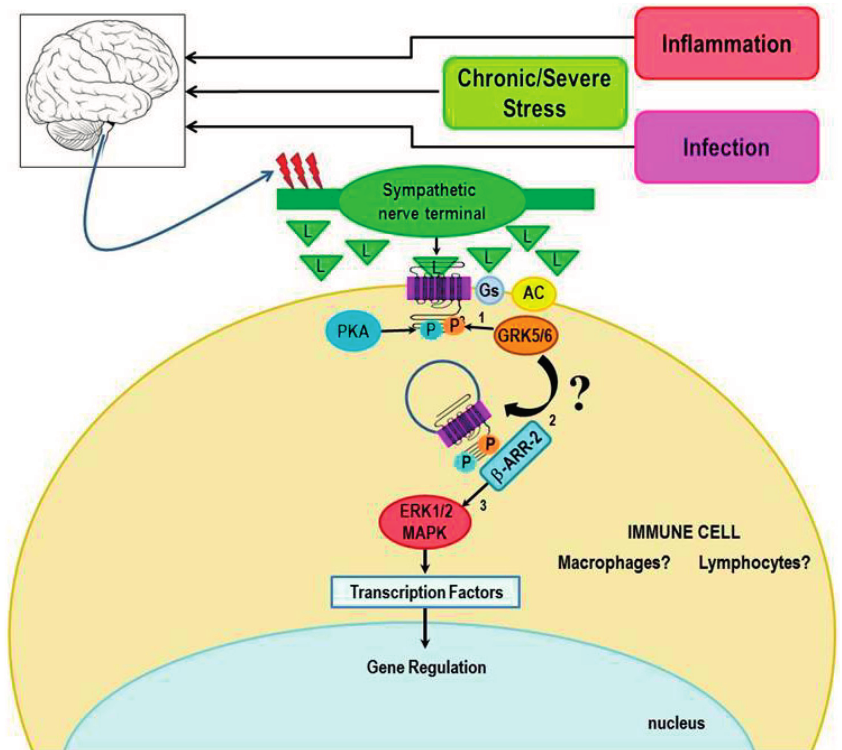
Figure 7. The hypothetical model for shifting β 2 -AR signaling from the canonical pathway towards the non-canonical pathway in immune cells is illustrated. We propose that signal transduction switching towards β -arrestin-mediated signaling occurs under conditions of unchecked immune cell activation or chronic or severe stress, both of which increase the firing rates of sympathetic nerves (red lightning bolts) and elevates local NE concentrations. These conditions favor the phosphorylation of the receptor by GRK 5/6 rather than GRK 2, thus promoting β -arrestin-2-mediated signaling via the MAPK,